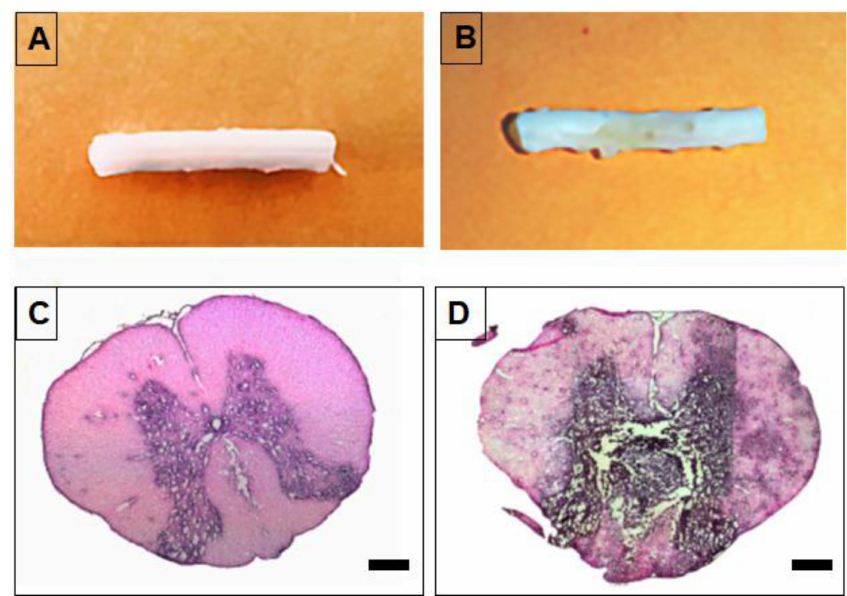
Figure 5. Generation of a rat T5 spinal cord tumor model at 12 days post-injection of C6 cells. ( A , B ) Representative images of isolated spinal cord and ( C , D ) H&E stained spinal cord section. ( A , C ) Normal spinal cord and ( B , D ) spinal cord with C6 cell-derived tumor. Scale bars indicate 500 µ m.